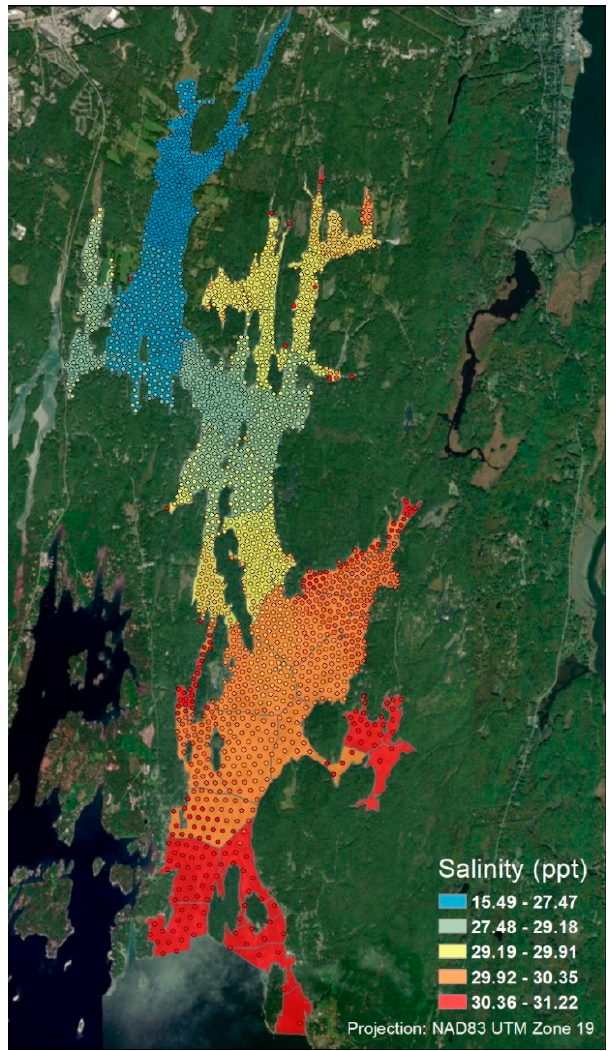
Figure 6. FVCOM model results summarized as a monthly mean (August mean salinity) associated with Voronoi cells in New Meadows River Estuary. All modeled values within a Voronoi cell are summarized as quantiles. Imagery base map sources: Esri, DigitalGlobe, Earthstar Geographics, CNES / Airbus DS, GeoEye, USDA FSA, USGS, Aerogrid, IGN, IGP, and the GIS User